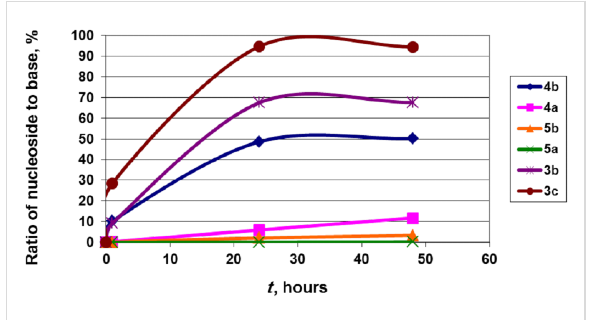
Figure 6: Progress of the formation of β -D-arabinofuranosides and 2-deoxy-2-fluoro- β -D-arabinofuranosides of 5-aza-7-deazaguanine 4b and 4a , and 8-aza-7-deazahypoxanthine 5b and 5a . Reaction condi- tions: reactions (1 mL) were performed in the presence of 2 μ mol hete- rocyclic base and 4 μ mol phosphate 12a (as a mixture of two anomers, so that the real quantity of the substrate 12a is half of the indicated quantity, i.e., 2 μ mol) or 10 μ mol arabinose-1-phosphate (real quantity of α -D-arabinofuranose-1-phosphate is 2 μ mol) in water at 50 °C for